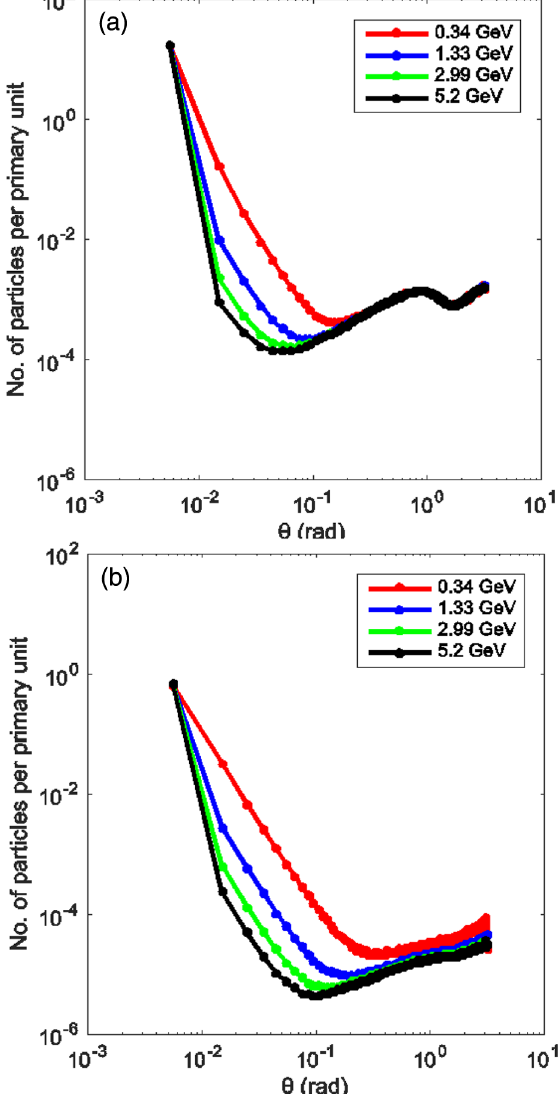
FIG. 8. Number of electrons (a) and photons (b) forward emitted in the collision of an electron beam with a 13 μ m tungsten wire as a function of the polar angle (rad) per primary incident particle for different beam energies: 0.340, 1.33, 2.99 and 5.2